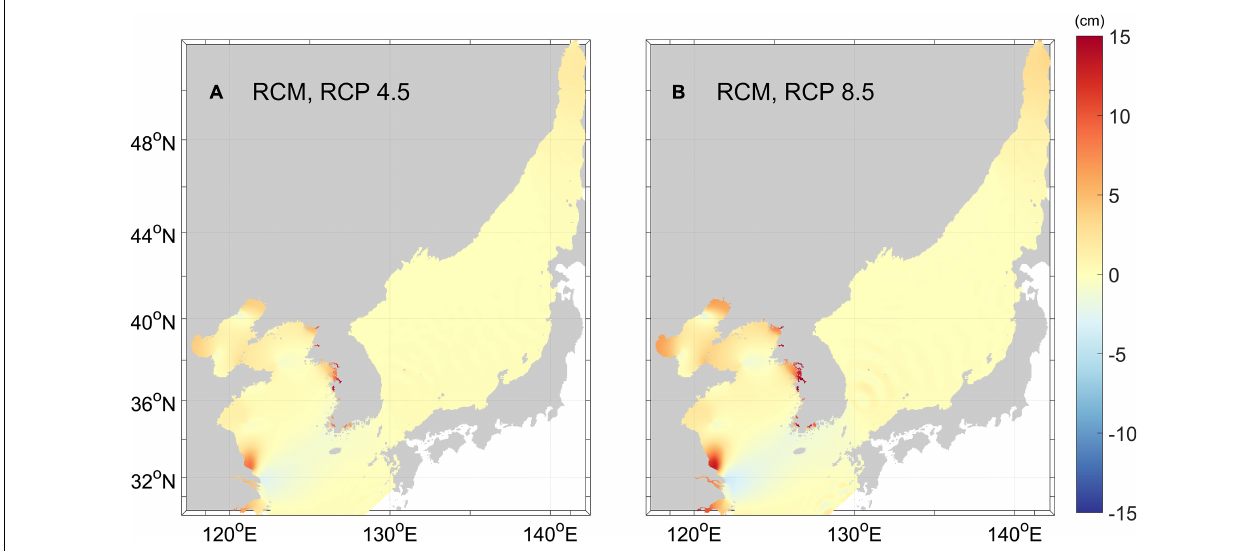
FIGURE 11 | Changes in the sum of the mean ensemble tidal amplitudes (unit: cm) for four major tidal constituents (M 2 , S 2 , K 1 , and O 1 ) of the RCMs between 2006 and 2100, for: (A) RCP 4.5, and (B) RCP 8.5 scenarios.